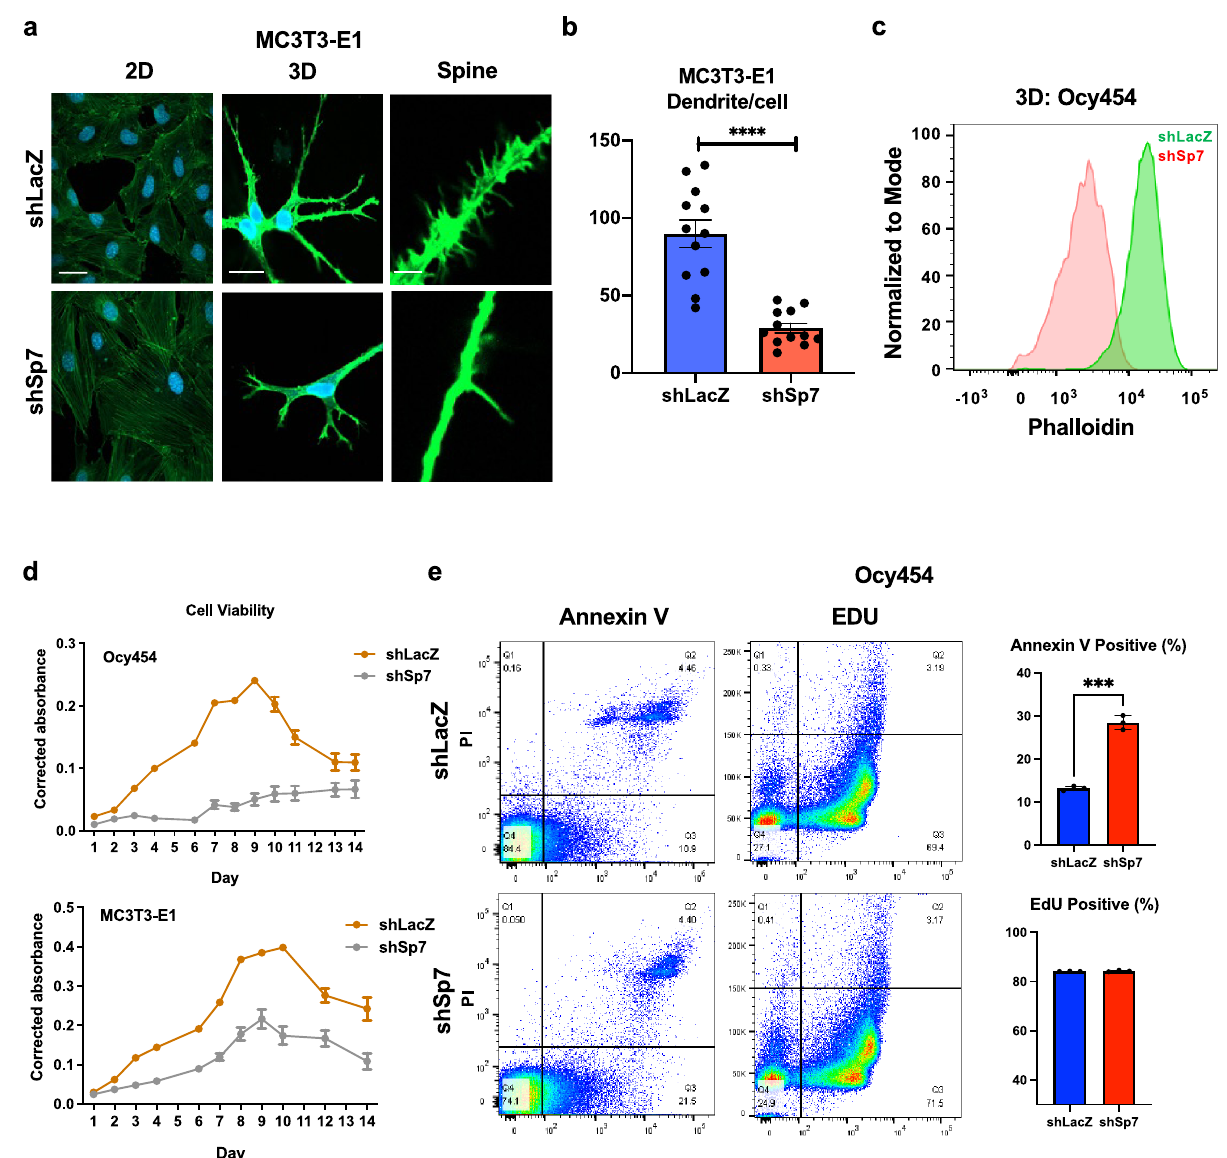
Fig. 2 Sp7 is required for optimal dendrite formation in vitro. a Control (shLacZ) and Sp7 knockdown (shSp7) MC3T3-E1 cells were cultured in standard (2D) or 3D (type I collagen gel) conditions, then stained with phalloidin (green) and DAPI (blue). In 3D culture, Sp7 knockdown cells show short dendrites (middle panel) with reduced complexity (right panel). Scale bars for 2D and 3D images represent 10 µ m, scale bar for “ spine ” images represent 1 µ m. b The number of dendrites per cell was measured in Sp7 knockdown and control cells grown in 3D culture. Each data point represents the dendrite number of an individually measured cell analyzed over three independent experiments. Two-sided student ’ s t test was used, **** indicates p < 0.0001. c Control and Sp7 knockdown Ocy454 cells were grown in 3D culture then stained with FITC-Phalloidin for fl ow cytometry. Reduced intracellular phalloidin staining is noted in Sp7 knockdown cells. d Growth curves for control and Sp7 knockdown Ocy454 cells (top) and MC3T3-E1 cells (bottom) were determined using a resavurin-based viability dye. n = 3 biologically independent samples were measured. e Control and Sp7 knockdown Ocy454 cells were analyzed in vitro for apoptosis and proliferation. Normal proliferation is noted based on EdU incorporation, whereas Sp7 knockdown cells show increased apoptosis. n = 3 biologically independent samples were measured. All data are presented as mean values ±SEM. Two-sided student ’ s t test was used, *** indicates p =